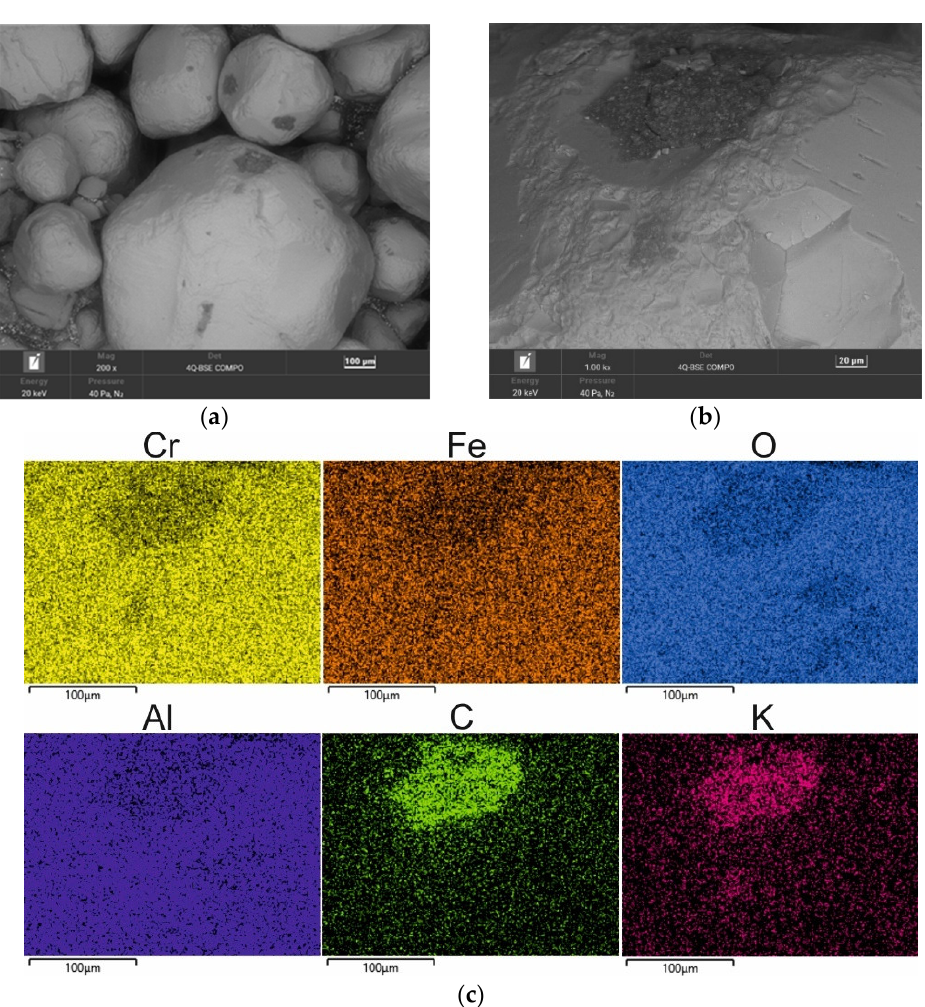
Figure 8. SEM image of 10 min MR10M-reclaimed sand: ( a ) mag. 200×; ( b ) mag. 1,000×; ( c ) EDS map of element distribution in the analysed area of MR10M reclaimed sand.